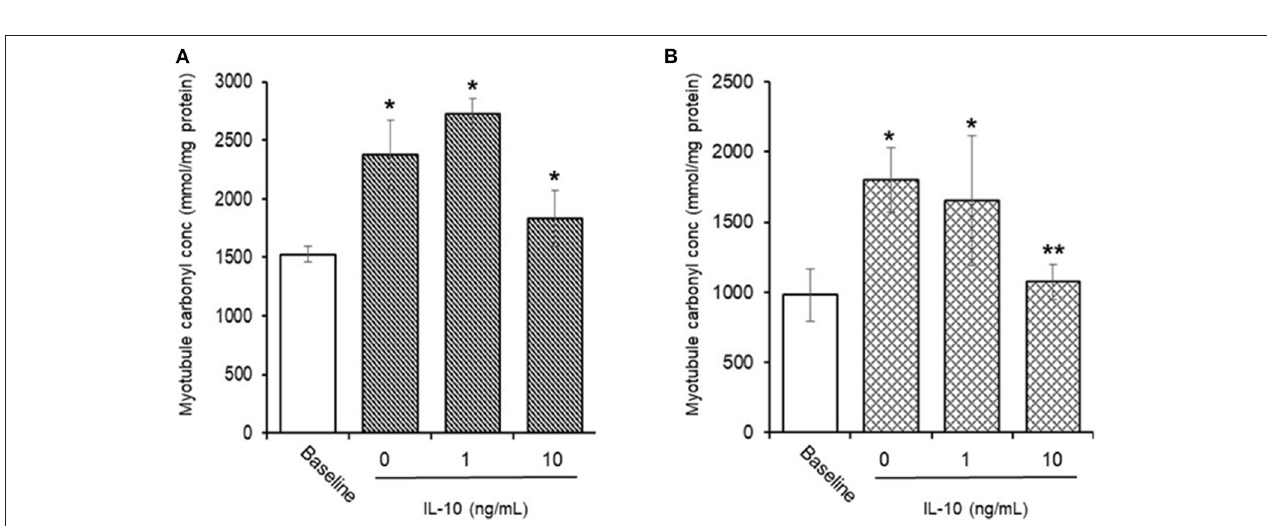
FIGURE 8 | Direct (A) or indirect (B) antioxidant action of IL-10 on AAPH-stimulated protein carbonyl content in differentiated mouse myotubules. Results are mean ± SEM of six separate experiments. * p < 0.05 and ** p < 0.05 represents statistical difference from un-stimulated (baseline) or AAPH-stimulated myotubule protein carbonyl content,